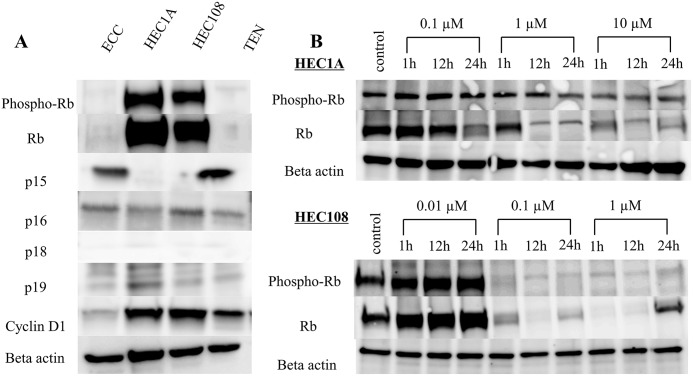
(A) A Western blot analysis shows the expression of Rb and phospho-Rb protein in HEC1A and HEC108 cells. Both cell lines demonstrated expression of cyclin D1. Strong expression of p15, p16, p18 and p19, which act as inhibitors of CDK 4/6, was not seen. (B) Effect of PD-0332991 on phosphorylation of Rb protein. HEC1A (top) and HEC108 (bottom) cells showed a time- and concentration-dependent inhibition of Rb phosphorylation following treatment with a PD-0332991 inhibitor. However, PD-0332991 inhibited total Rb expression to a greater extent than phospho-Rb.